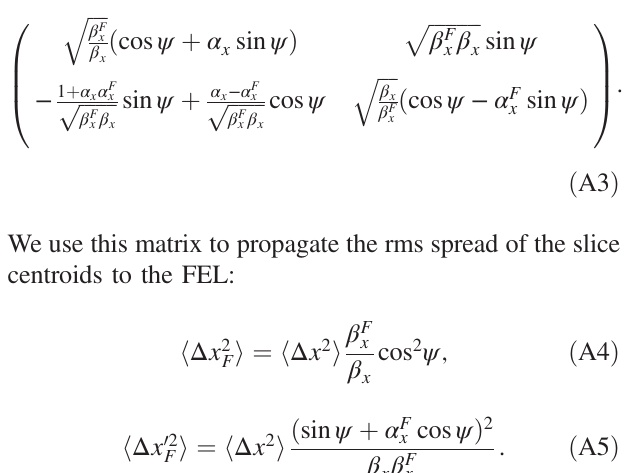
FIG. 5. The gray thick segment along the diagonal is the set of points representing the centroids of the beam slices as observed at the exit of the achromat. One can minimize the projected emittance by choosing the design Twiss functions according to Eq. (A1) to make the unperturbed beam ellipse at the exit of the beam line (red curve) align with this set. In contrast, an unperturbed beam represented by the green ellipse would maximize the projected